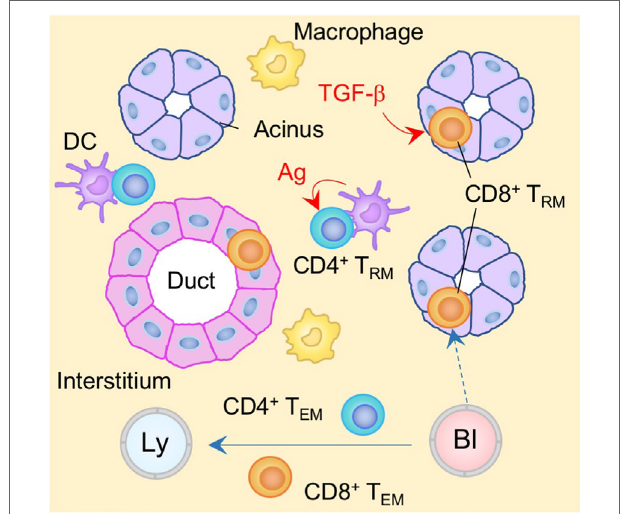
FiGURe 5 | T RM niches in the in the salivary gland (SG). CD8 + T RM cells are localized predominantly within the epithelium of the acini and duct. Local TGF- β signaling is required for the formation of CD8 + T RM cells in the SG. By contrast, CD4 + T RM cells are localized predominantly within the stroma of the SG. In contrast to CD8 + T RM cells, cognate antigen plays a key role in the formation of CD4 + T RM cells. T EM cells are passing through the normal interstitium. Red lines indicate the representative niche factors that influence the maintenance of T RM cells. Orange and blue cells indicate CD8 + and CD4 + T RM cells, respectively, unless otherwise stated. A blue line indicates the migratory route. A dashed line indicates potential migratory route. Abbreviations: Ly, lymph vessel; Bl, blood vessel; Ag, antigen; T RM , tissue-resident memory T cells; T EM , effector memory T